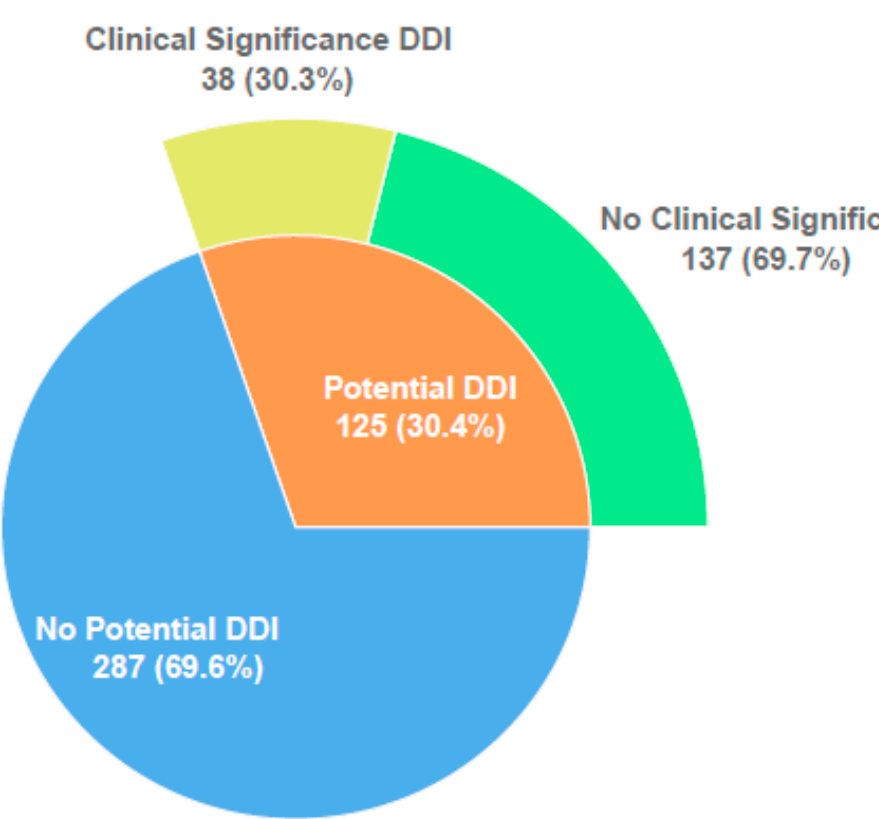
Figure 1. Distribution of potential and clinically relevant DDIs.